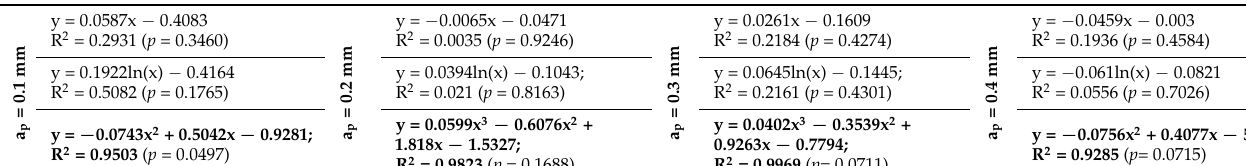
Table 6. Results of mathematical modelling of the Ssk parameter as a function of the feed rate for different values of the depth of cut (regression functions y = Ssk(f z ); f z = x with the coefficient of determination R 2 ).